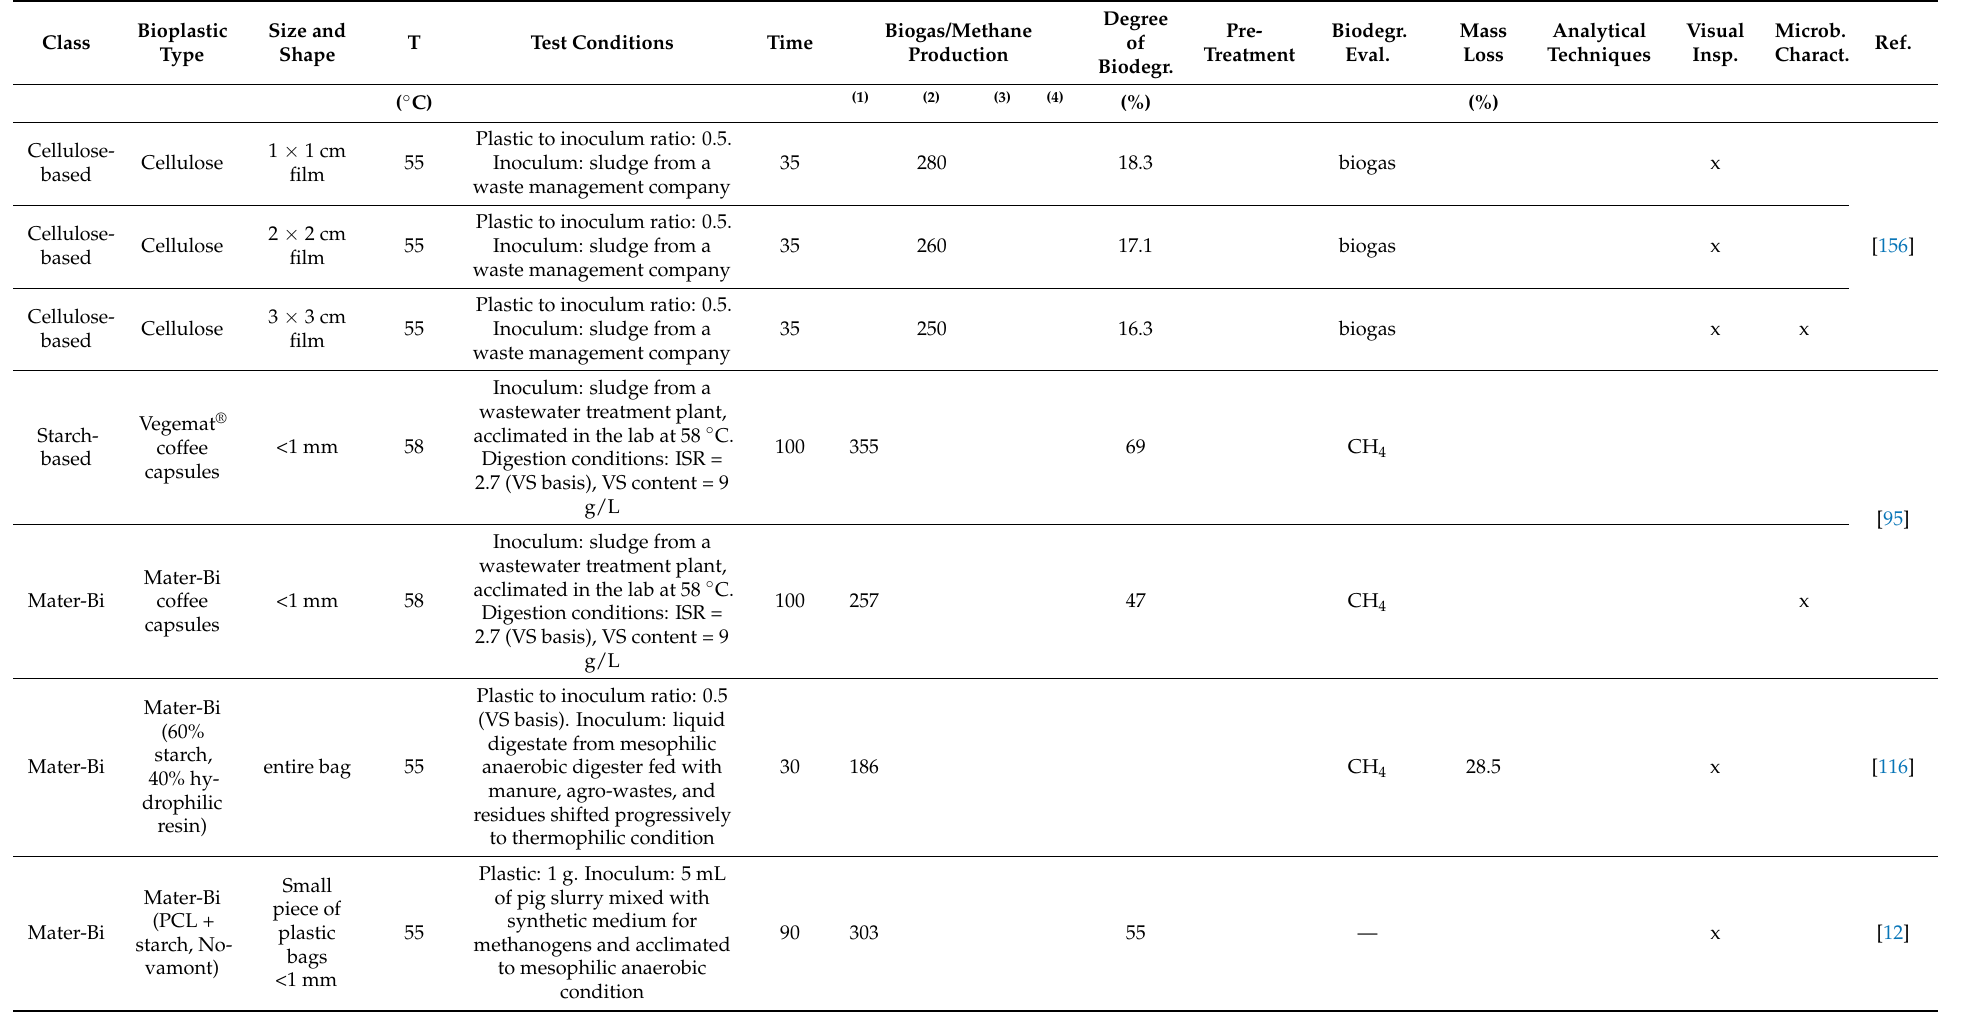
Table A2. Summary of literature results related to anaerobic degradation of different bioplastic products under thermophilic conditions (expanded from